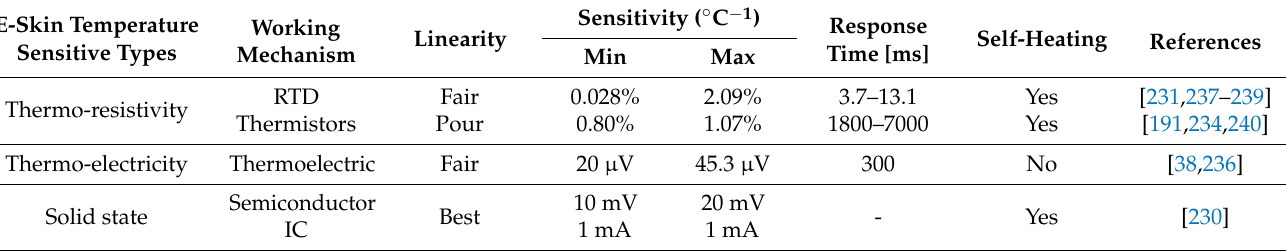
Table 3. E-skin Temperature Sensors